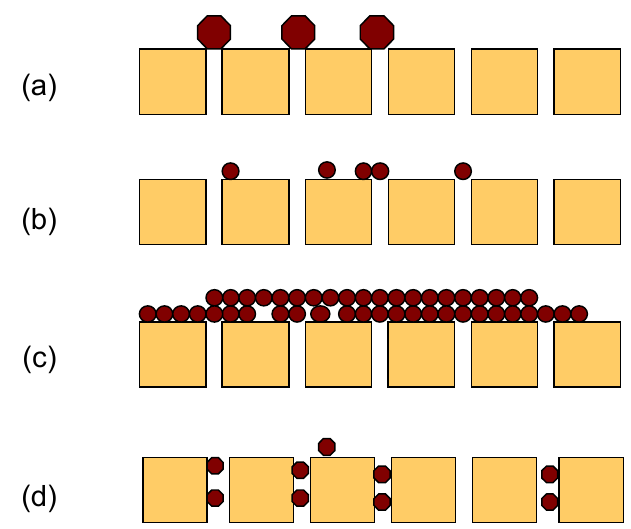
Figure 4. Scheme of fouling mechanism: complete pore blocking ( a ); partial pore blocking ( b ); cake filtration ( c ); internal pore blocking ( d